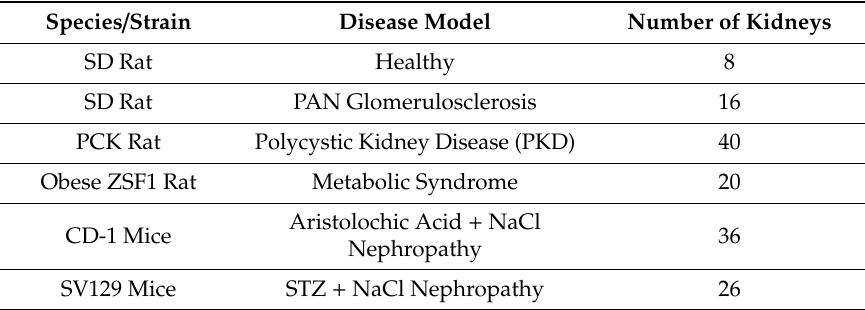
Table 1. Summary of the murine and rat models utilized in